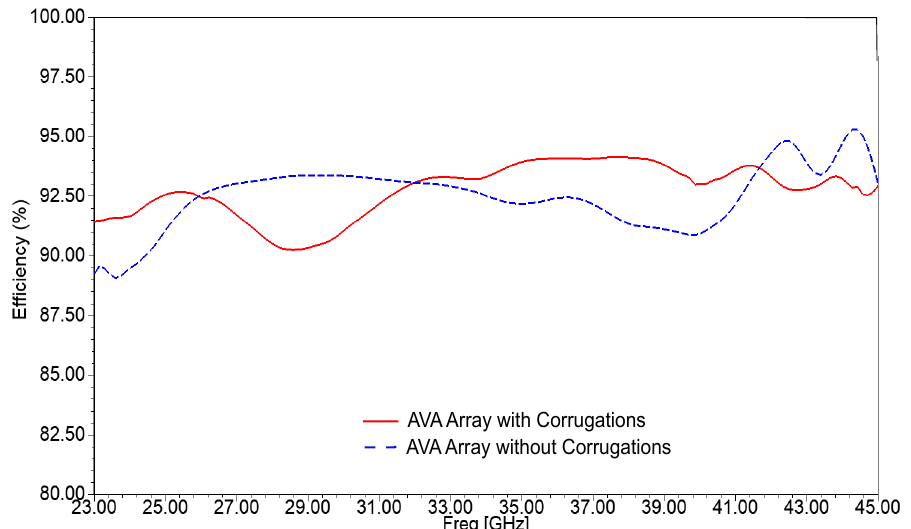
Figure 18. Simulated efficiency of the AVA array with and without